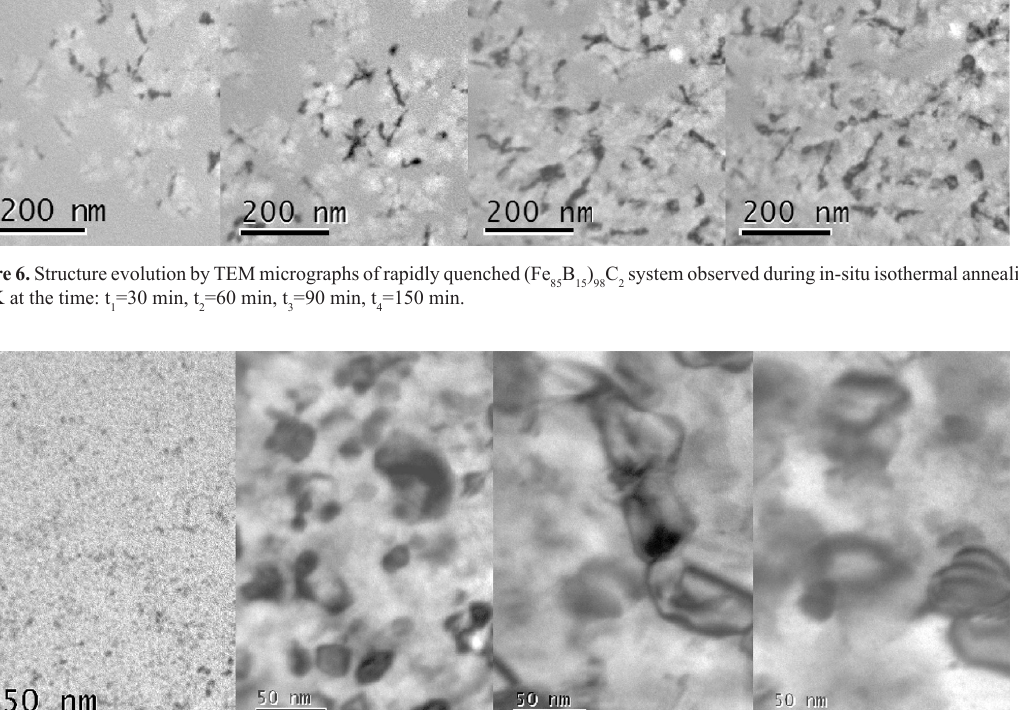
B Si ) C system observed during in-situ isothermal 85 10 5 98 2